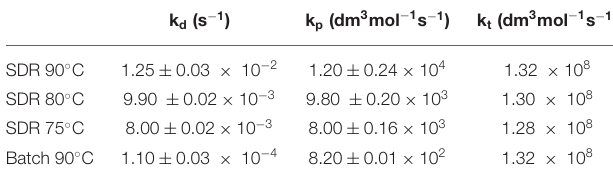
TABLE 4 | Polymerization rate constants k d , k p , and k t at different temperatures in a